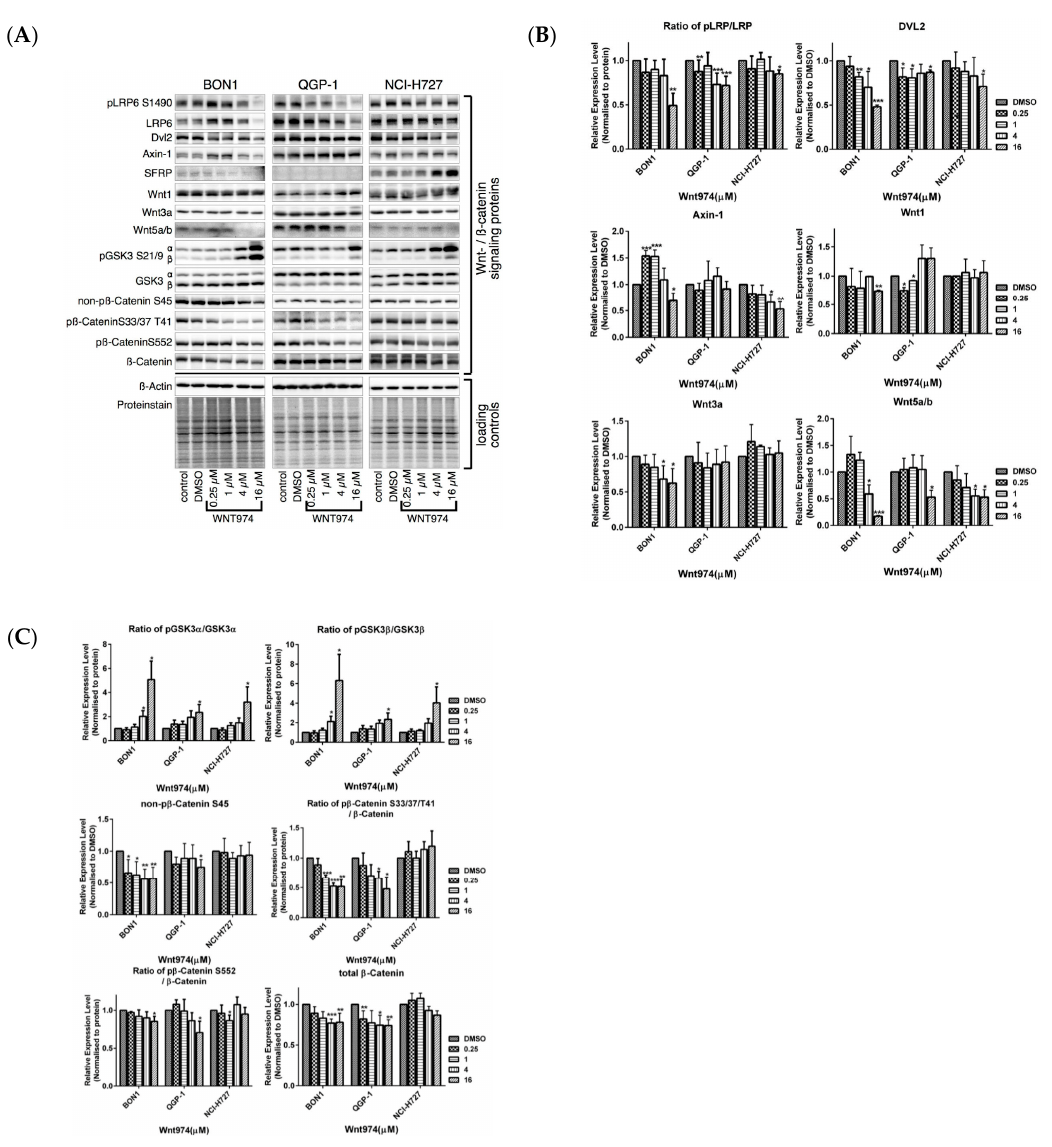
Figure 4. E ff ects of WNT974 on inhibition of the Wnt / β -catenin signaling in NET cells. BON1, QGP-1, and NCI-H727 cells were treated with or without WNT974 for 72 h and then subjected to Western blot analysis. ( A ) A representative Western blot is shown. Equal protein loading was verified in all Western blots by normalization to the total protein staining and by the housekeeping protein β -actin. ( B , C ) Densitometric quantification of Western blot data was performed. The DMSO control was set as 1.0. Relative expression levels (normalized to DMSO control) of treated cells were calculated in %. * p < 0.05, ** p < 0.01, and *** p < 0.001 compared with that of DMSO controls.